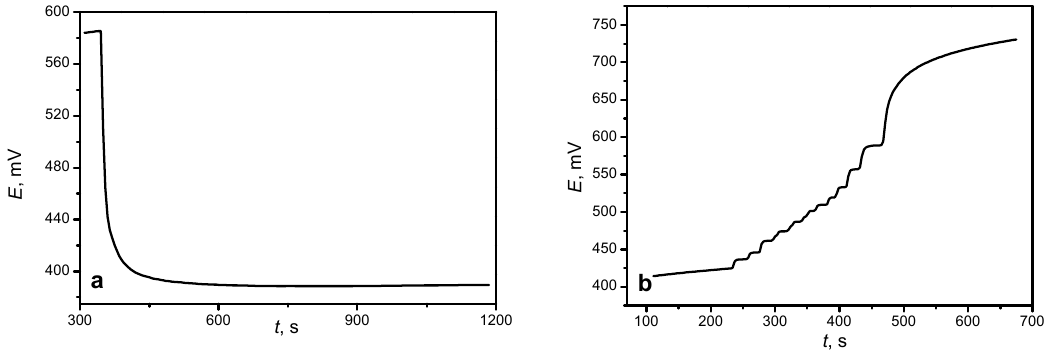
Figure 8. The change in the Ox-Red potential over time: ( a ) in the LiFePO4/C dissolution process; ( b ) in the titration process.